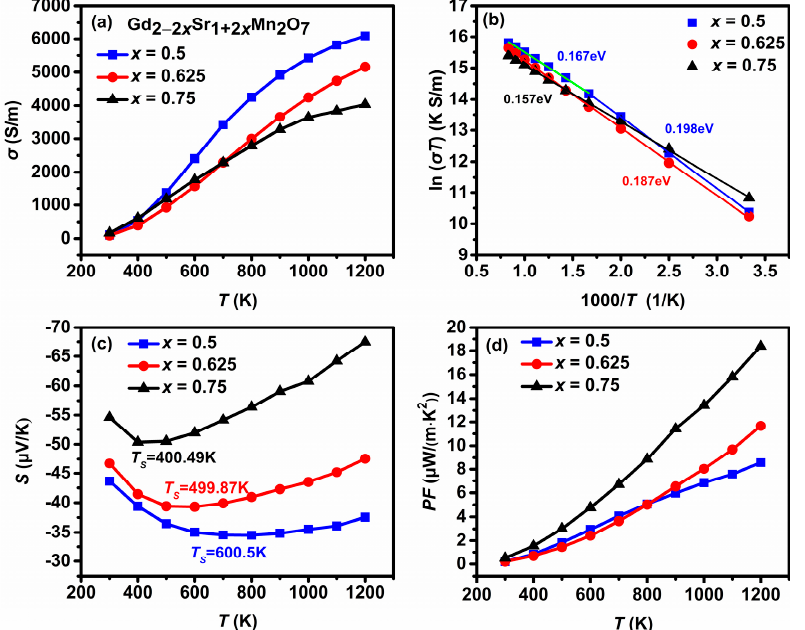
Figure 3. ( a ) Temperature dependence of the electrical conductivity, ( b ) plot of ln( σ T ) versus 1000/ T . The solid lines represent the fitting of the small polaron hopping model. Temperature dependence of ( c ) the Seebeck coefficient, and ( d ) the power factor for Gd 2 − 2 x Sr 1+2 x Mn 2 O 7 ( x = 0.5, 0.625,